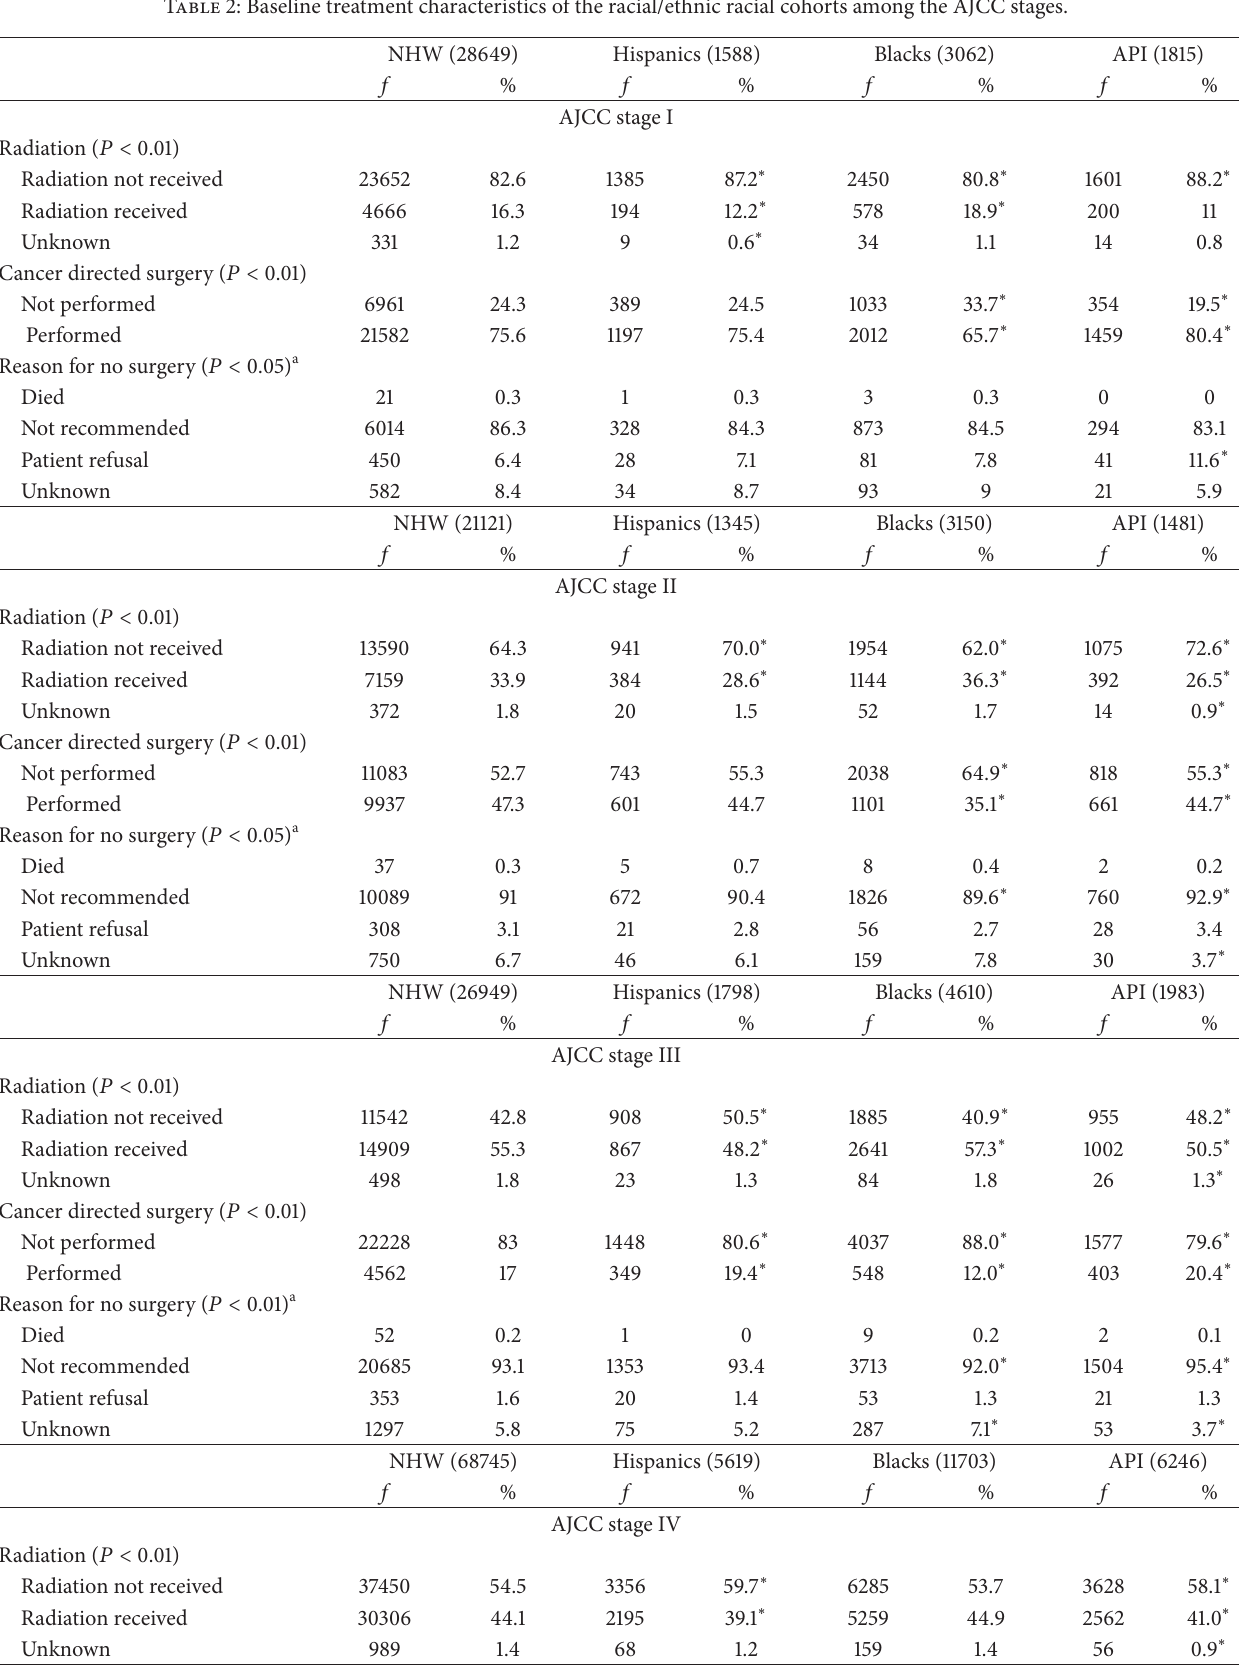
Table 2: Baseline treatment characteristics of the racial/ethnic racial cohorts among the AJCC